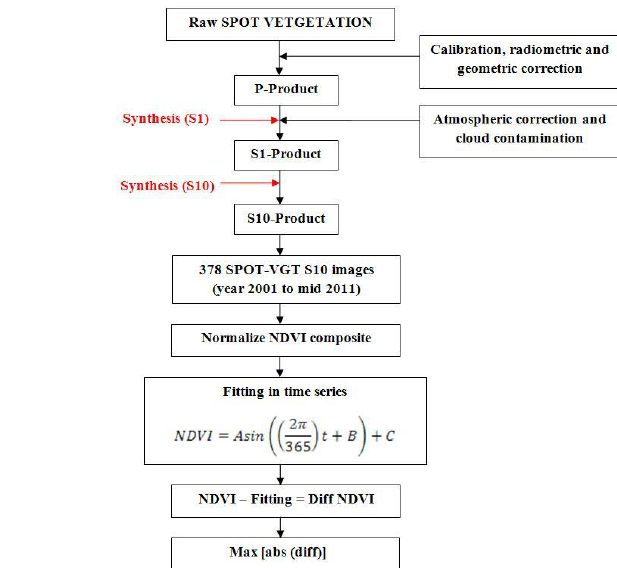
Figure 3. Processing